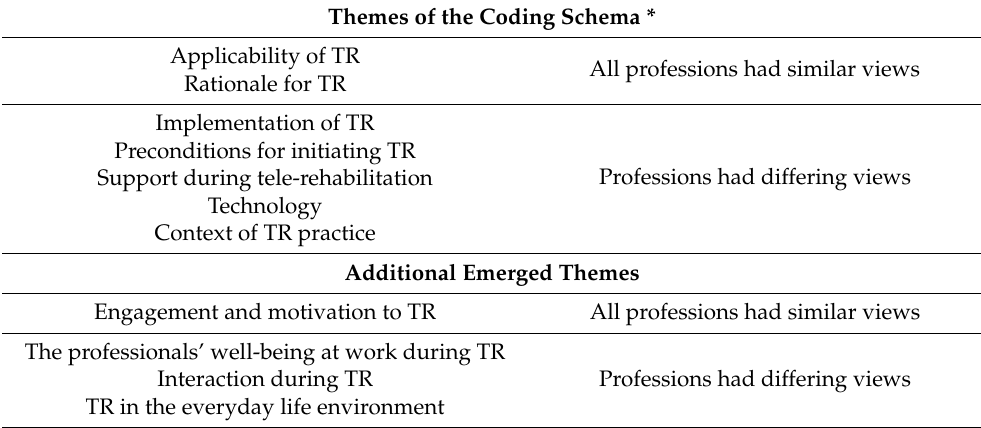
Table 5. The themes of the qualitative analysis.